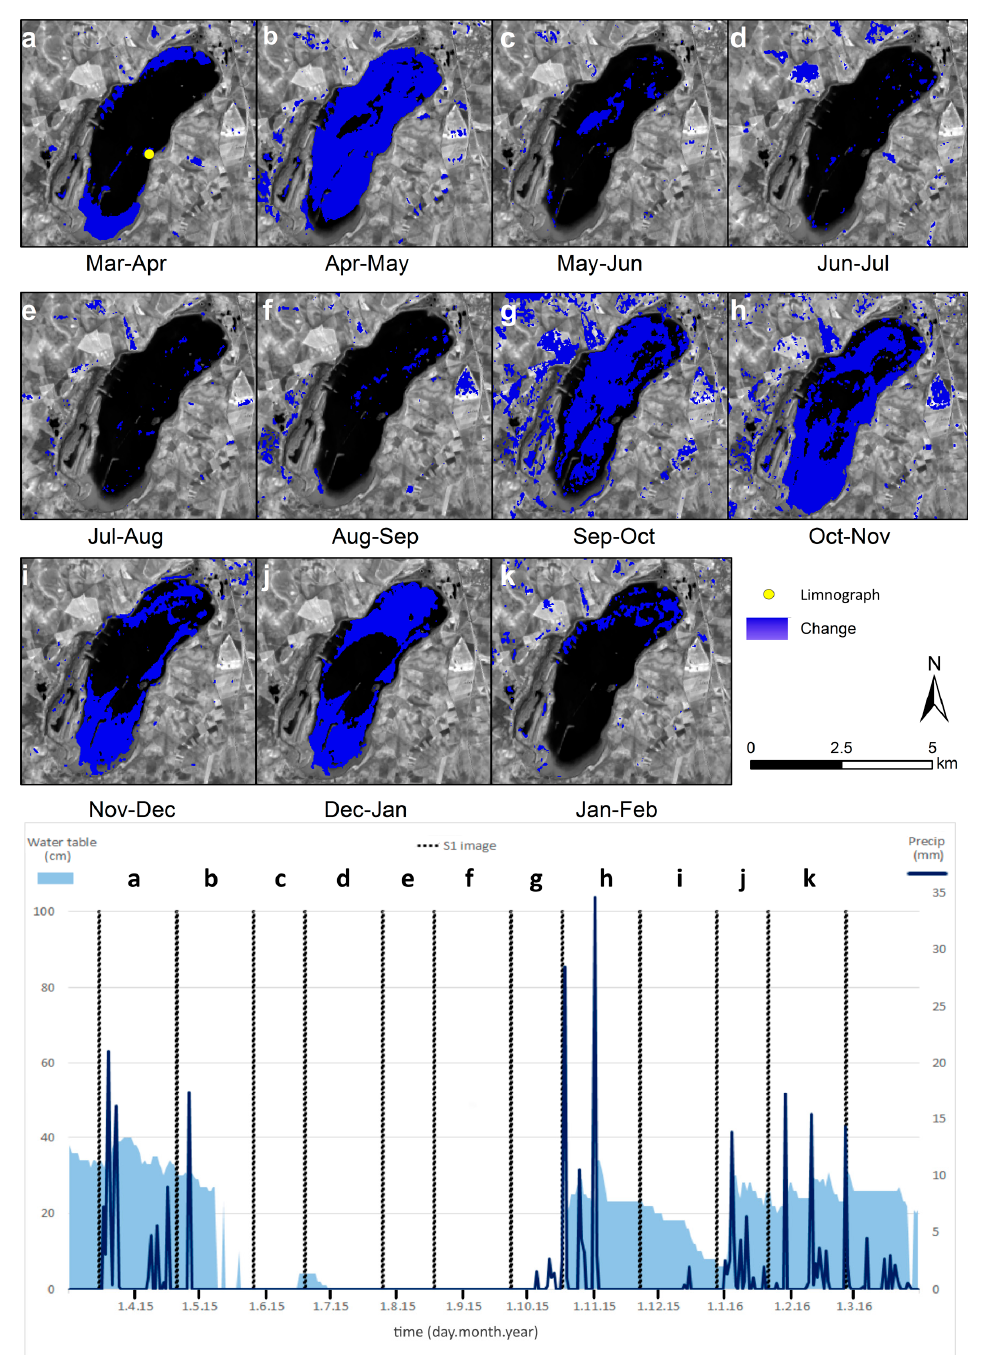
(Figure 2h), November and December (Figure 2i) and December and January (Figure 2j) match the records of the limnograph. Remote Sens. 2016 , 8 , 795